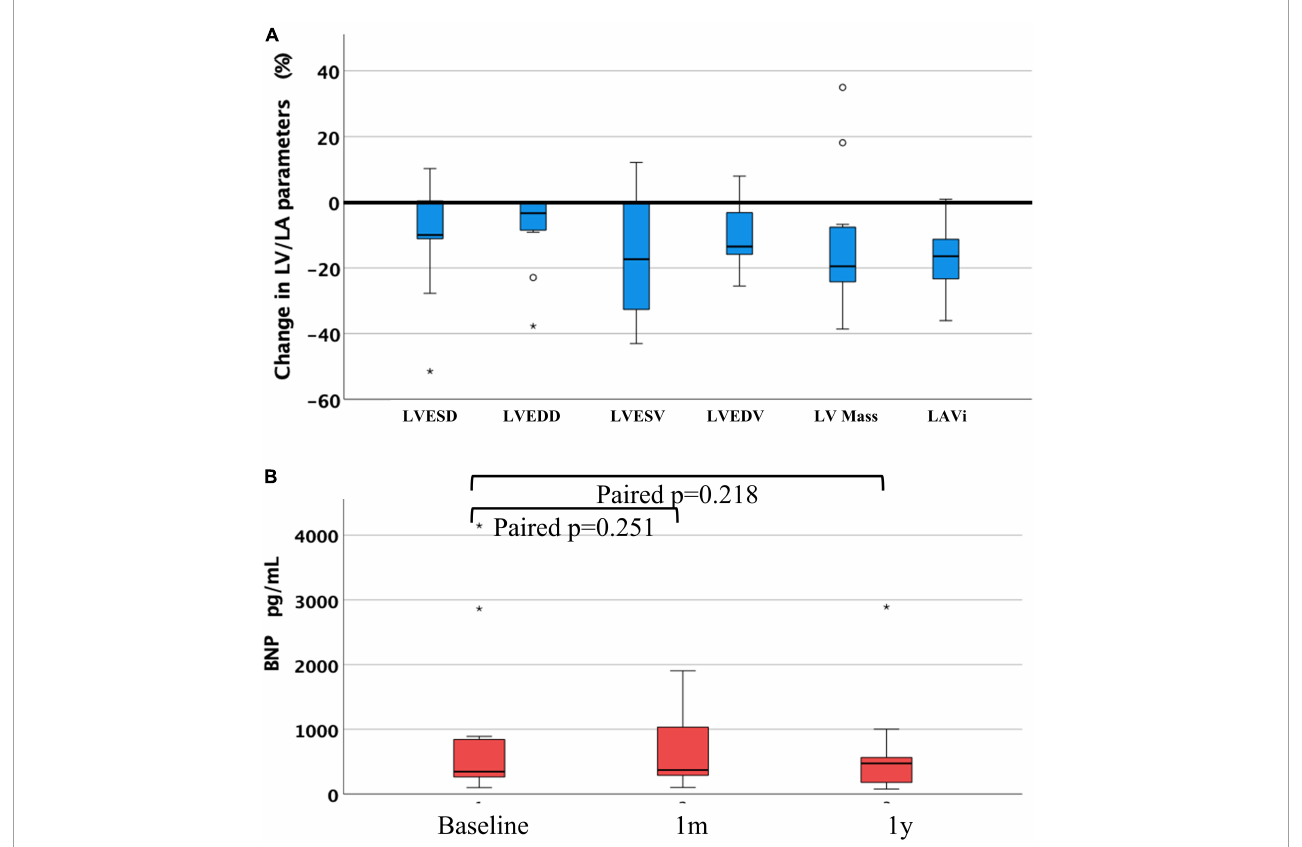
FIGURE3 (A) Change ratio of left ventricular and left atrial parameters between at baseline and at 1 year after the procedure, and (B) difference of BNP at 1 month and at 1 year after the procedure compared with baseline. LVESD, left ventricular end-systolic diameter; LVEDD, left ventricular end-diastolic diameter; LVESV, left ventricular end-systolic volume; LVEDV, left ventricular end-diastolic volume; LV mass, left ventricular mass; LAVi, left atrial volume index; BNP, brain natriuretic peptide, “ ◦ ” and “*” denote outliers.